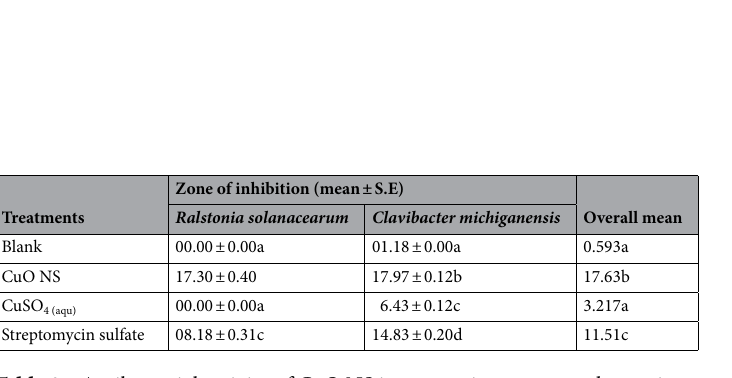
Table 2. Antibacterial activity of CuO NS in comparison to control